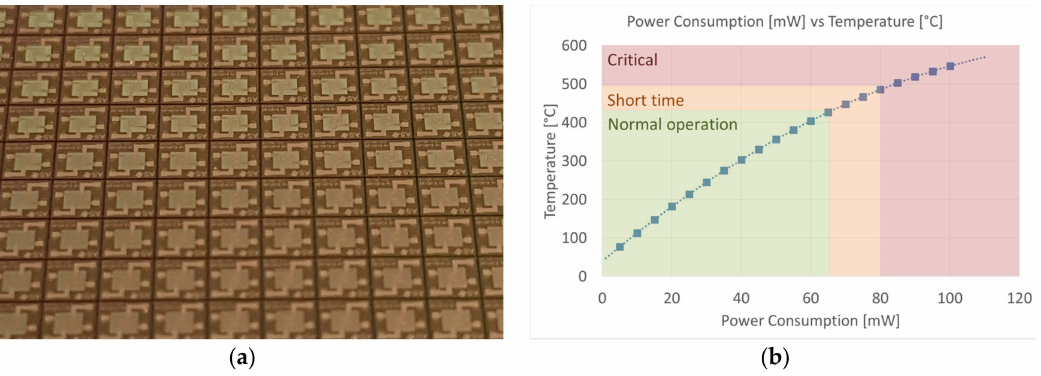
Figure 1. ( a ) Optical image of a wafer of ams E120:20 µ HPs. ( b ) Power consumption versus temperature